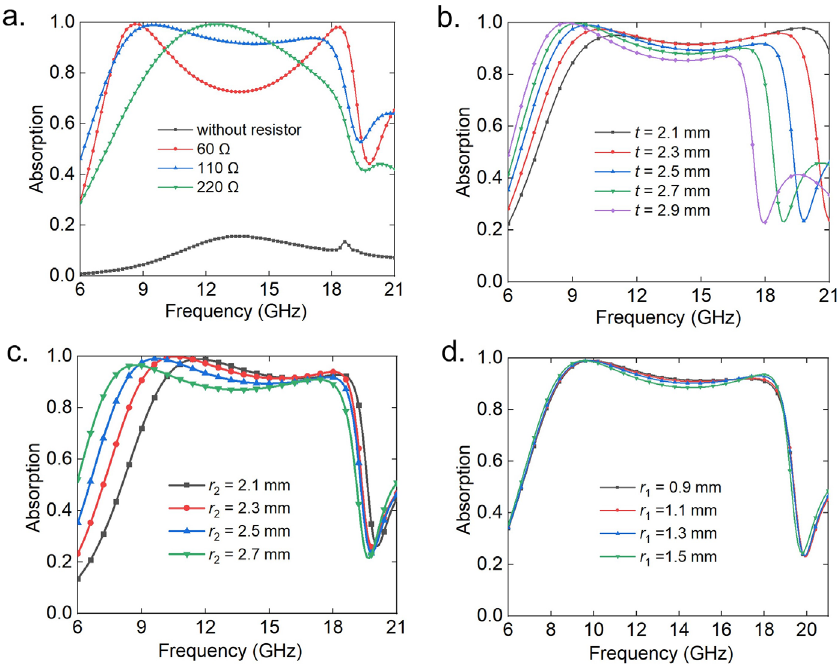
Fig. 3. Parameter study of the proposed metamaterial absorber. The frequency-dependent absorption performance of the absorber as a function of (a) the numerical value of the chip resistors, (b) the dielectric substrate thickness t , (c) the outer radius r 2 of the split circular ring on the top layer, and (d) the inner radius r 1 of the split circular ring on the top layer.